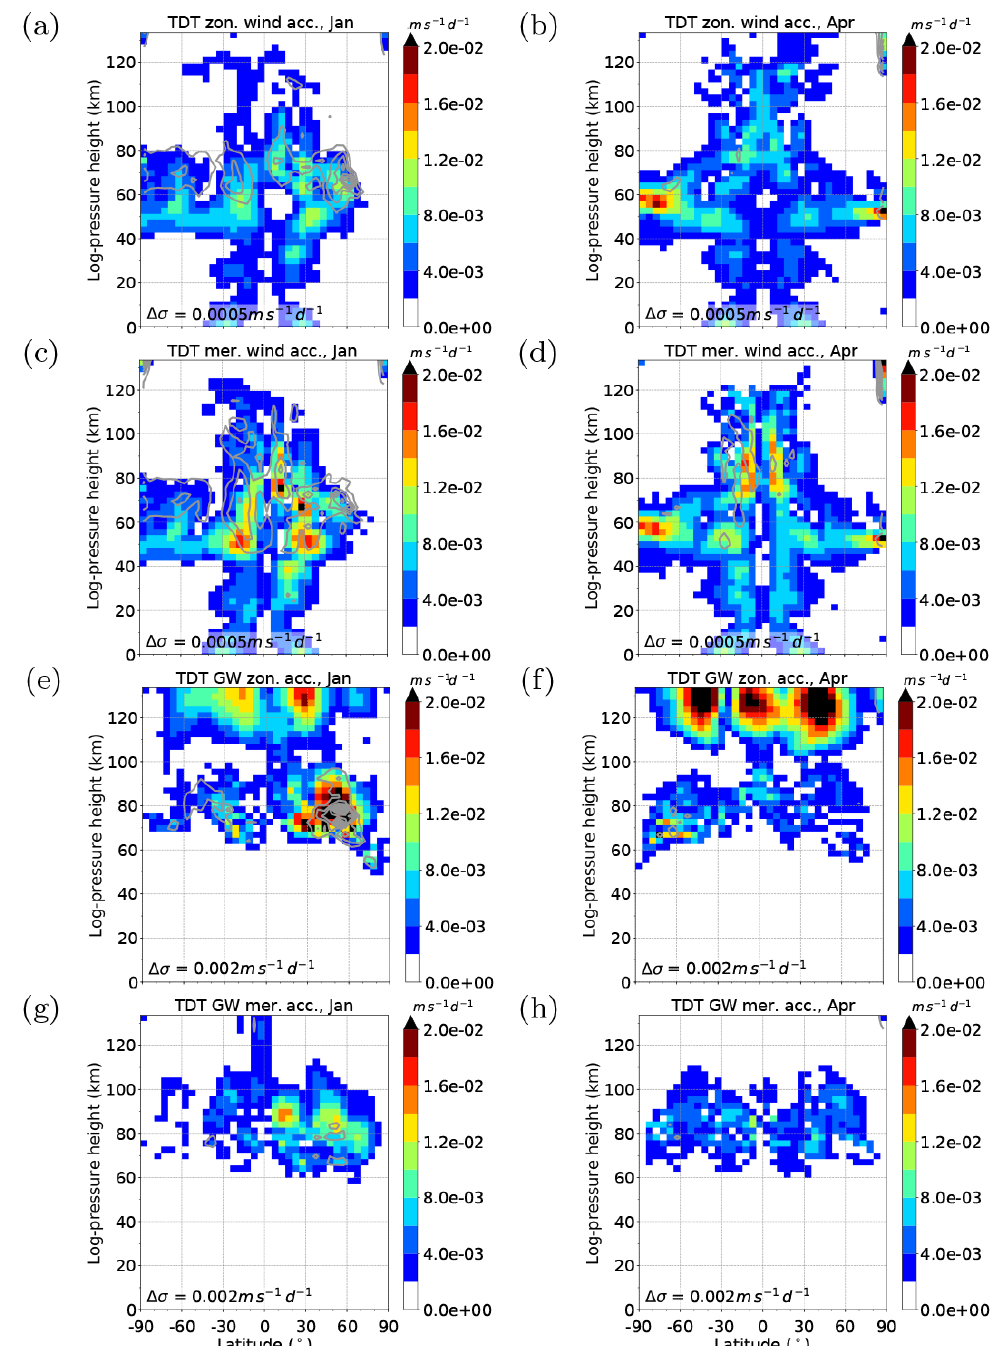
Figure 3. Terdiurnal component of zonal and meridional wind acceleration terms in the REF simulation for January conditions (a, c, e, g) and April conditions (b, d, f, h) . Amplitudes are scaled by exp {− z( 2 H) − 1 } . Results are an average of the 11 ensemble members (color shading). Standard deviations ( σ ) are added as gray contour line. (a, b) Zonal wind advection (nonlinear component of Eq. 2), (c, d) meridional wind advection (nonlinear component of Eq. 3) and (e, f) zonal and (g, h) meridional acceleration due to gravity waves (tendency terms from gravity wave